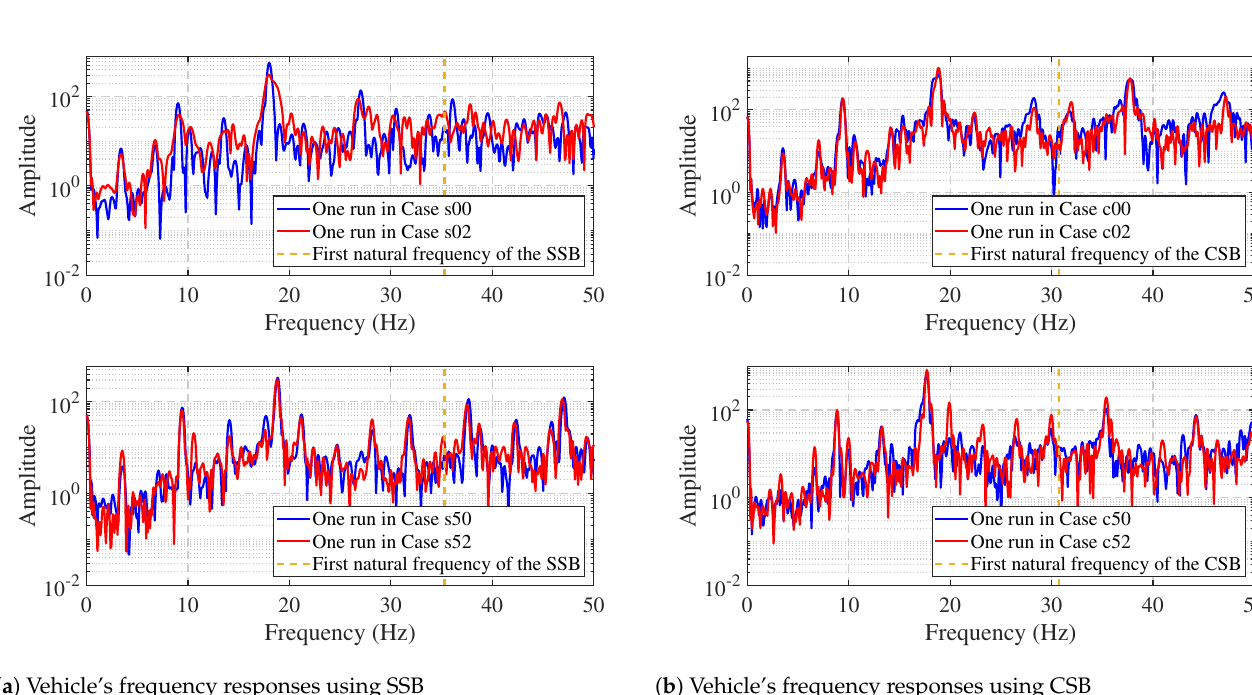
Figure 11. Vehicle’s frequency responses at 0–50 Hz.